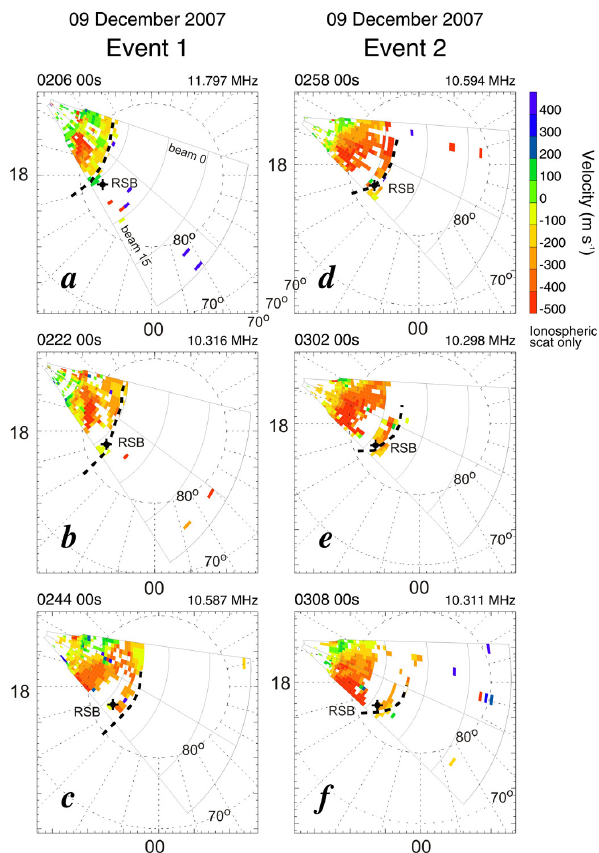
Fig. 3. A series of Inuvik radar velocity maps recorded on 9 Decem- ber 2007. Mapping is done in MLAT-MLT coordinates. Range ticks within the radar field-of-view correspond to gates 15, 30, 45 and 60. Dashed lines indicate locations of the polar cap arcs. Panels (a) – (c) and (d) – (g) correspond to the events 1 and 2, respectively.